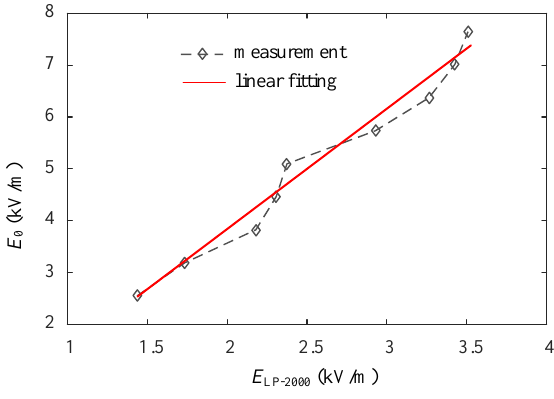
Figure 12. Relation curve of stimulation and uncorrected experimental data (in the case of an approaching human body).